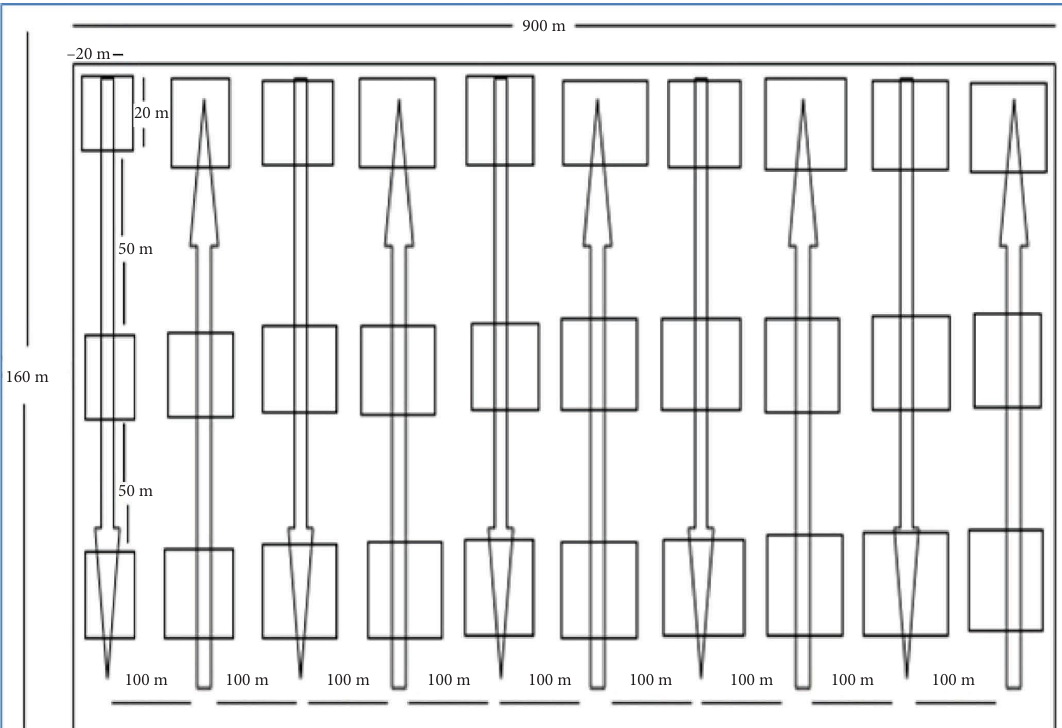
Figure 2: Layout of the sampling plots (transects and quadrats).